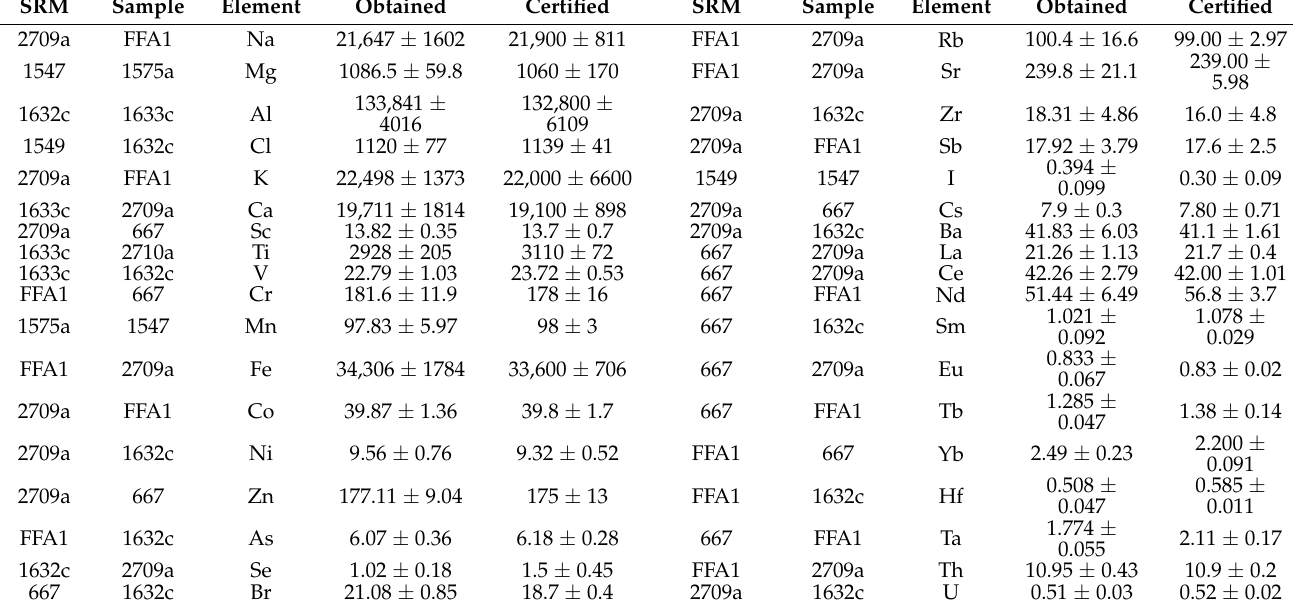
Table 1. Epithermal Neutron Activation Analysis (ENAA): obtained and certified values of reference materials, mg/kg. SRM Sample